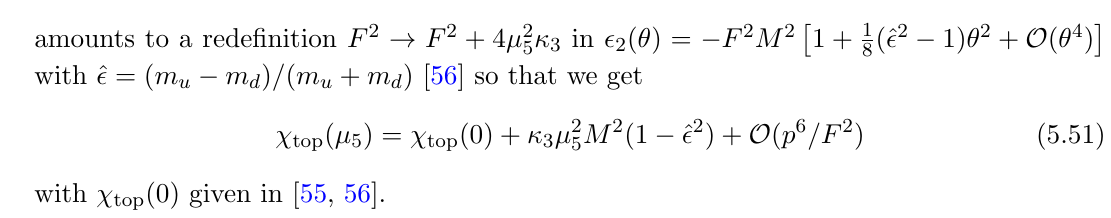
Figure 6 . (cid:22) 5 dependence of the topological susceptibility chiral transition temperature extracted from the vanishing of the quark condensate. We show the uncertainty bands corresponding to j (cid:20) 3 j